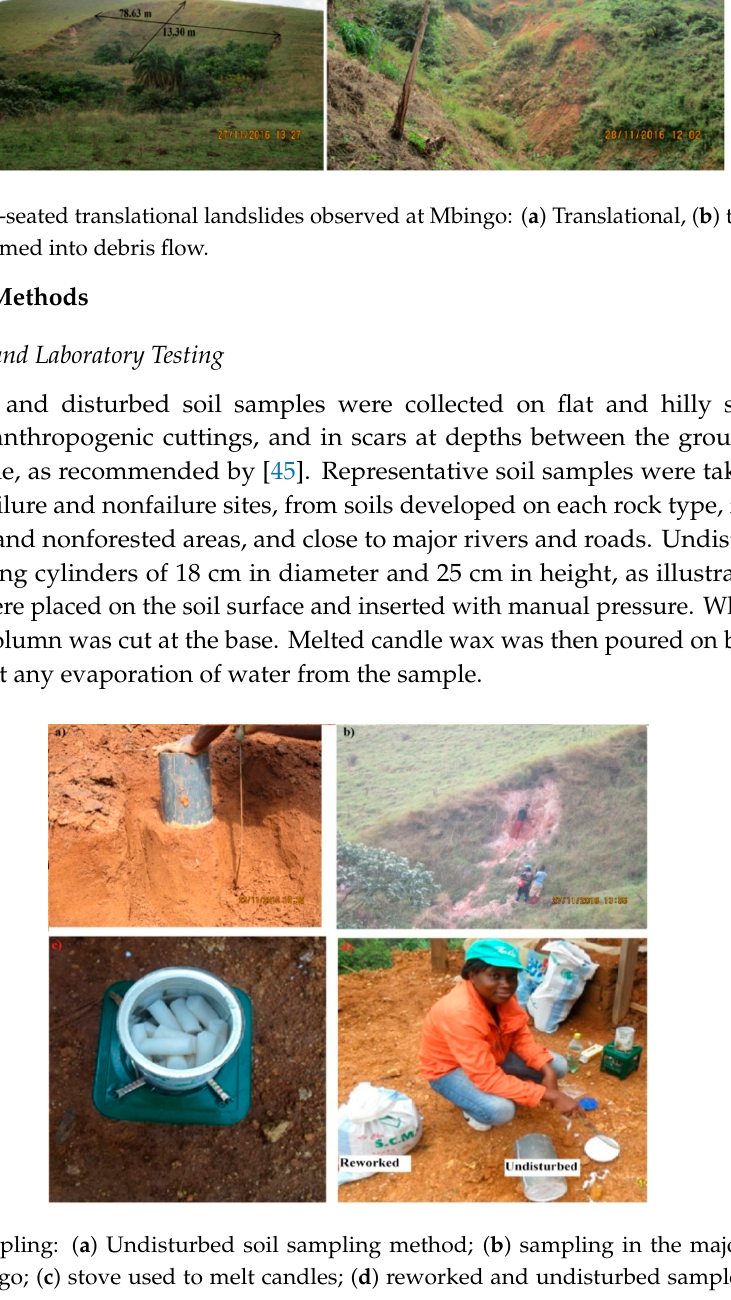
Figure 4. Deep-seated translational landslides observed at Mbingo: ( a ) Translational, ( b ) translational failure transformed into debris flow.